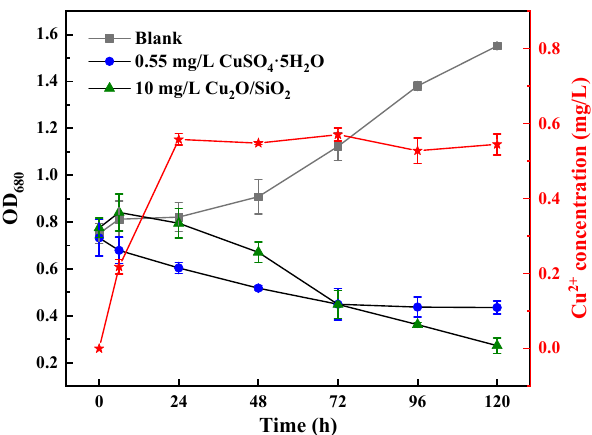
Figure 3. The concentration of Cu 2+ released by Cu 2 O/SiO 2 in solution and its effect on the growth of M. aeruginosa .